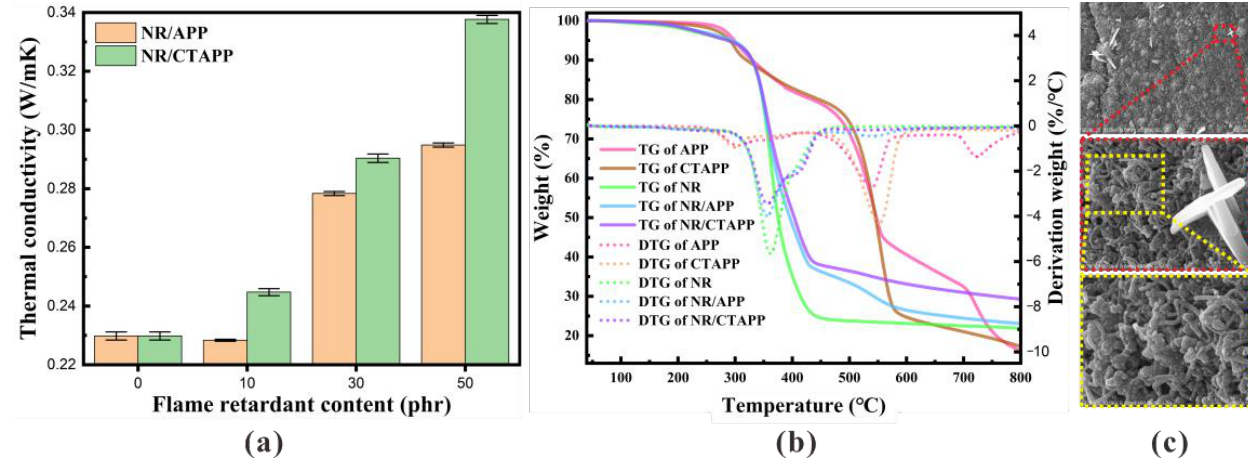
Figure 8. ( a ) Thermal conductivity of composites. ( b ) TGA analysis curves of APP, CTAPP, NR,